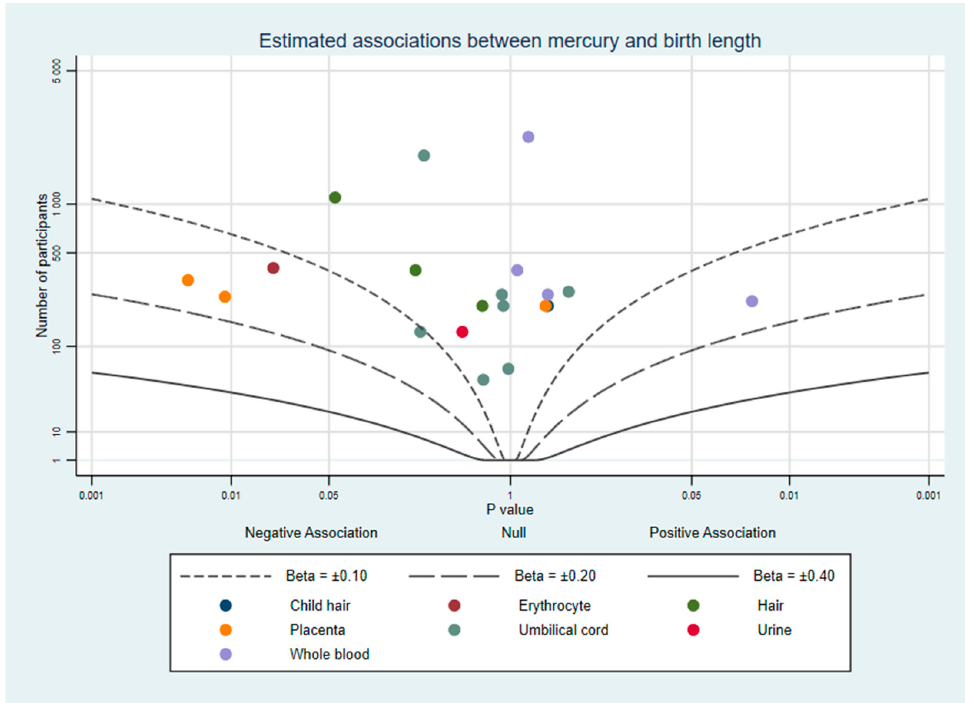
Figure 4. Albatross plot of the estimated effect of mercury exposure on birth length.